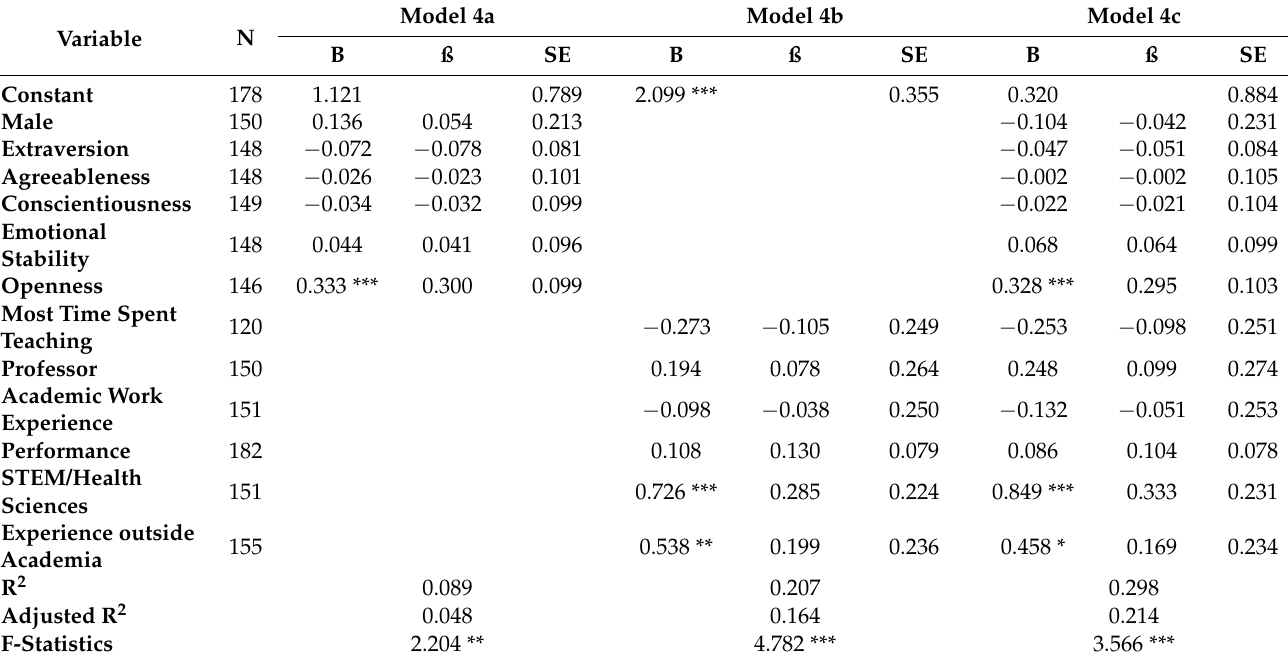
Table A4. Multiple regression models for predicting engagement in applied contract research activities.